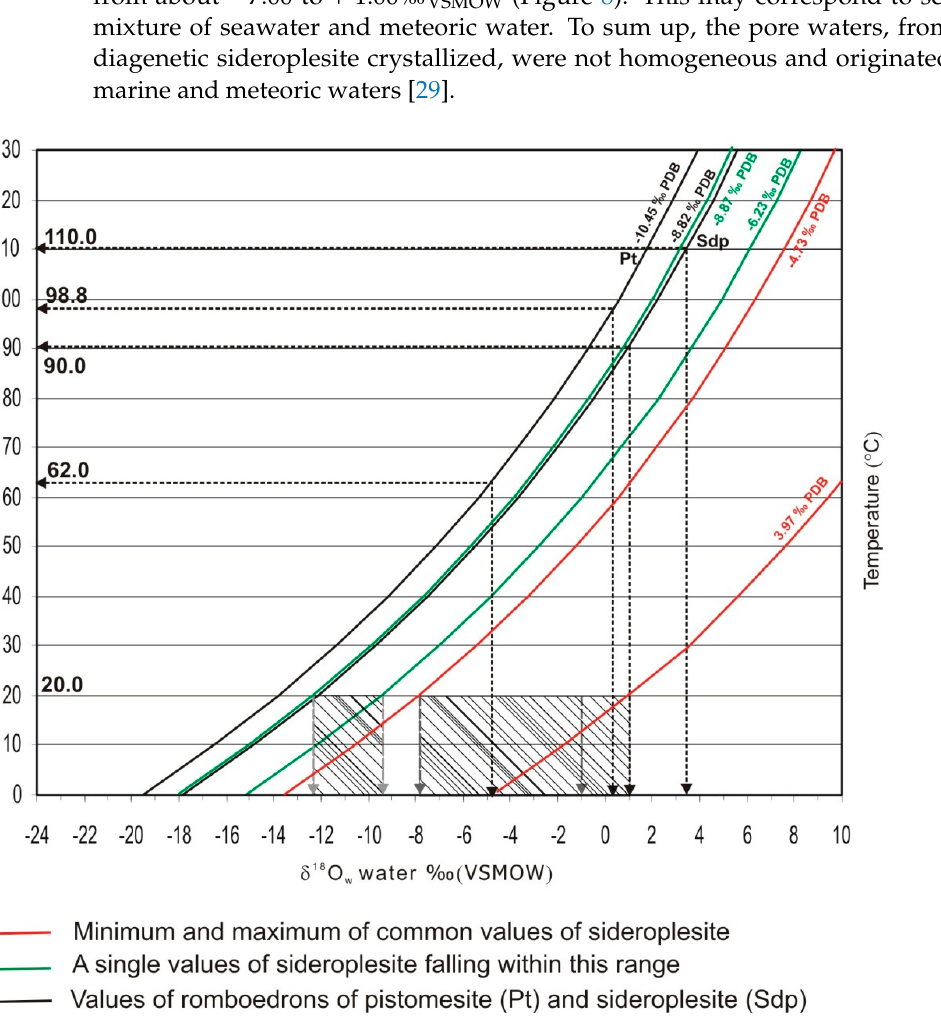
Figure 8. Plot of the δ 18 O pore water versus temperature for siderite cements (after Reference [119]). The average δ 13 C and δ 18 O values of sideroplesite in a given age range are as follows: − 7.02 and − 1.52‰ VPDB for the Aalenian, − 5.80 and − 0.77‰ VPDB for the Bajocian, and − 12.26 and − 0.52‰ VPDB for the Bathonian. The data revealed a constant source of CO 2 from the Aalenian to the Bathonian and a slight increase in the δ 18 O level. The pore water in the Aalenian, from which the sideroplesite crystallized, was slightly depleted in the 18 O iso- tope compared to the pore water in the Bajocian and Bathonian. The rhombohedral crystals of sideroplesite and pistomesite were formed at a later stage of diagenesis, which was supported by the isotope data (Table S5) and the homoge- nization temperature of fluid inclusions in the range of 62.0–110.0 °C [29] from the W ę glany borehole. These minerals precipitated from pore water (from approximately − 5.00 to +3.50‰ VSMOW ) more enriched in the 18 O isotope compared to water from which